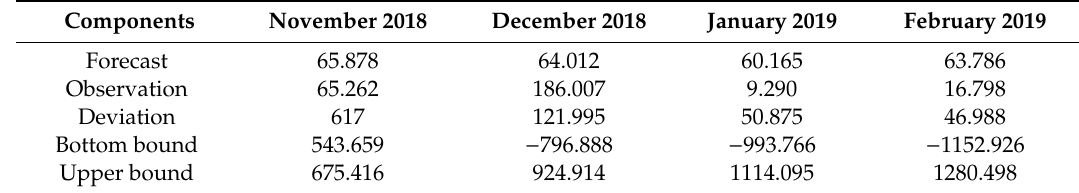
Figure 8. Forecasted profits in 95% confidence interval of Bank A. Table 6. The forecasted profit of Bank A in million IDR.